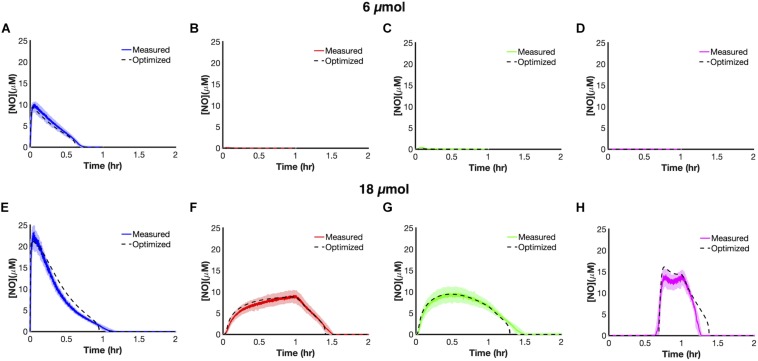
Model training and optimization on NO dynamics observed at 6 μmol (A–D) and 18 μmol (E–H) for the four principle dosing modes (refer to Supplementary Table S6 for a list of optimized parameters). Cultures of E. coli were grown to exponential phase and inoculated in a bioreactor at an OD600 of 0.05. Five minutes after inoculation, PAPA NONOate was delivered over an hour in one of four ways (bolus- blue; constant-red; ramp down-green; ramp up-pink). Solid lines represent the mean of three independent experiments, whereas the lightly shaded areas represent the standard error of the mean. Dashed black lines represent simulation results using the ensemble of parameter sets (ER < 10, 28 sets in total) trained on the data presented in this figure. Simulations from the ensemble members greatly overlapped, thus resembling a single line.